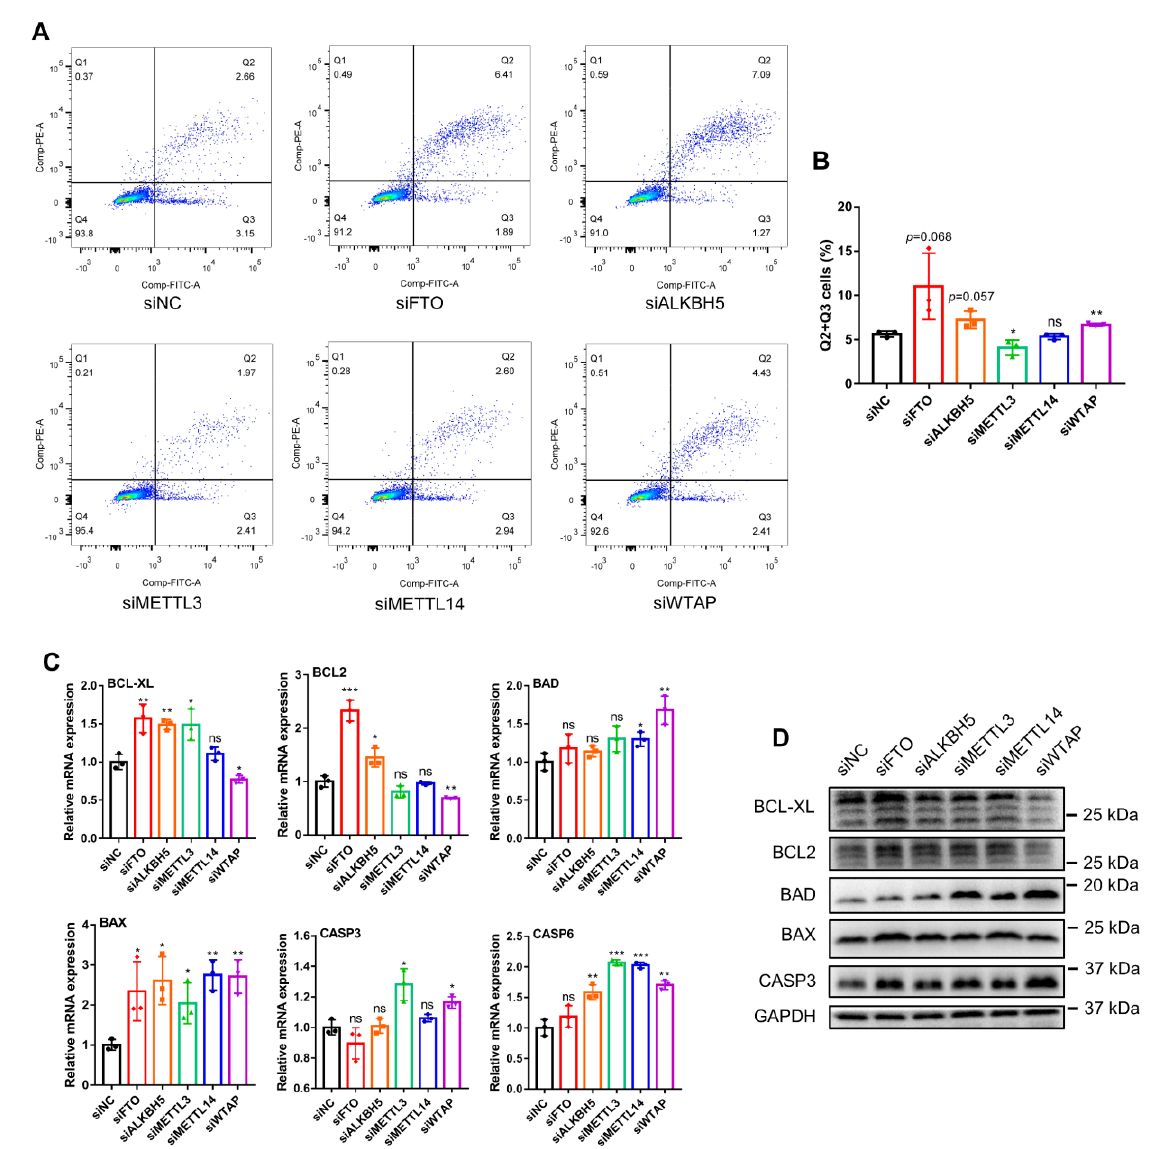
Figure 4. Knockdown of m 6 A methylase genes regulates bovine myoblast apoptosis. Bovine my- oblasts were transfected with siNC or siRNAs (siFTO, siALKBH5, siMETTL3, siMETTL14 or siWTAP) for 36 h. ( A , B ) Flow cytometry detection and analysis and the percentage of apoptotic cell counts. Q1 is cell debris, Q2 is late apoptotic cells, Q3 is early apoptotic cells, and Q4 is live cells. ( C ) RT-qPCR was performed to detect the relative mRNA expression of apoptosis-related genes, including BCL-XL , BCL2 , BAD , BAX , CASP3 and CASP6 . GAPDH was the normalization control. ( D ) Western blot assays demonstrating the expression levels of BCL-XL, BCL2, BAD, BAX, CASP3 and GAPDH proteins in different treated cells. ( B , C ) Results are presented as the means ± SDs from three independent experiments. Using Student’s t test, * p < 0.05, ** p < 0.01, *** p < 0.001 and ns = no significance.